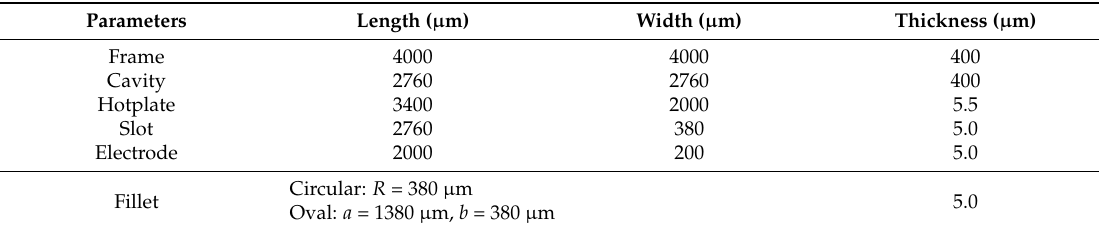
Table 2. Structure and dimension parameters of emitters used in